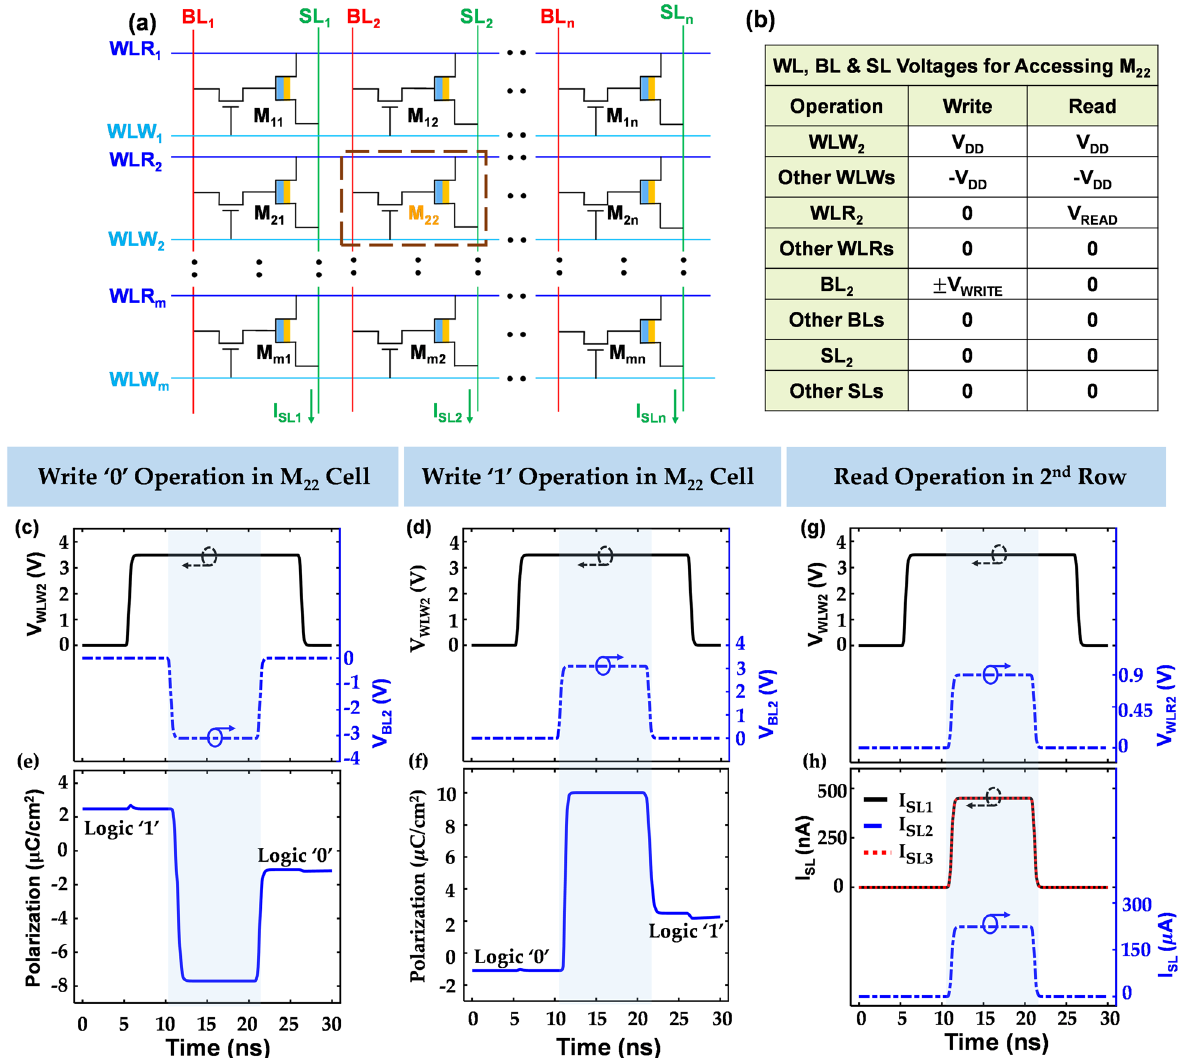
Figure 3. Mott-FeFET array operation. ( a ) Schematic of the proposed Mott-FeFET-based memory array. ( b ) Biasing scheme for WLWs, WLRs, BLs and SLs to access a memory cell (M 22 here). The results presented here are for a 3 × 3 array. Time dynamics of the bias voltages applied across WLW2 and BL2 during ( c ) write ‘0’ and ( d ) write ‘1’ operations in the M 22 cell. During write operation, the other WLWs and BLs are biased at V DD and 0 V, respectively, and all the WLRs and SLs are biased at 0 V. Time evolution of the ferroelectric polarization for ( e ) write ‘1’ → ‘0’ and ( f ) write ‘0’ → ‘1’ operations in the M 22 cell. ( g ) Temporal dynamics of the bias voltages